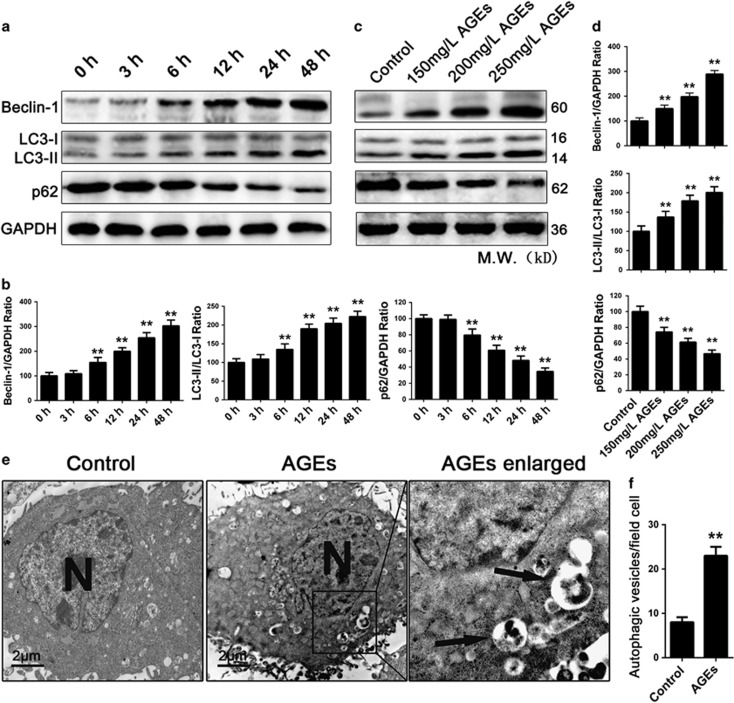
AGEs affected the expression of autopaghy-related proteins and promoted the formation of autophagic vesicles in mesangial cells. (a) Western blot analysis of Beclin-1, LC3II/LC3I and p62 protein levels in mesangial cells treated with 250 mg/l AGEs for 0, 3, 6, 12, 24, 48 h. (c) Western blot analysis of Beclin-1, LC3II/LC3I and p62 protein levels in mesangial cells treated with various concentrations of AGEs (150–250 mg/l) for 24 h. (b and d) Quantitative analysis of Beclin-1, LC3II/LC3I and p62 protein expression. The data are presented as the mean±S.E.M. from at least three independent experiments. **P<0.01 versus 0 h or Control. (e) Transmission electron microscopy showed autophagic vesicles (bold arrows) in cells that had been treated with 250 mg/l AGEs for 24 h. Bar=2 μm. (f) Quantification of the autophagic vesicles in 10 randomly selected cells. The data are presented as the mean±S.E.M. **P<0.01 versus Control